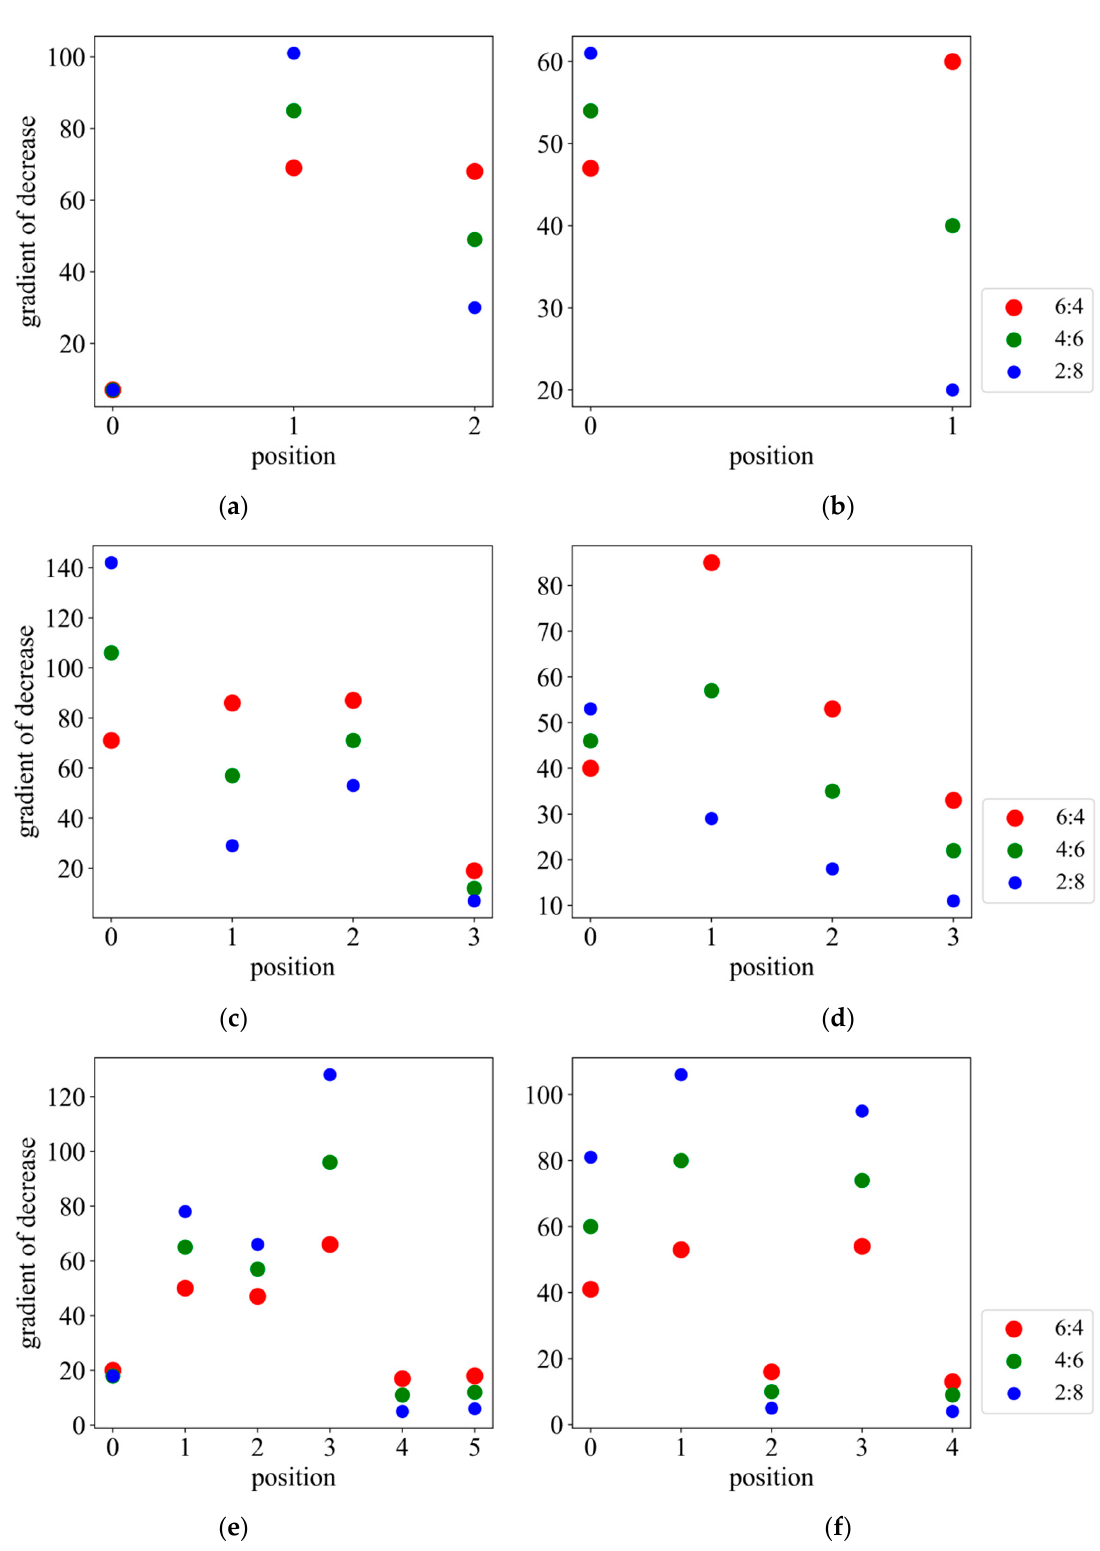
Figure 8. Scatter plots of gradient of decrease near the lake boundary with different weight settings: ( a ) result of the 14th row of Landsat TM image; ( b ) result of the 16th row of Landsat TM image; ( c ) result of the 18th row of Landsat ETM+ image; ( d ) result of the 19th row of Landsat ETM+ image; ( e ) result of the 19th row of Landsat OLI image; ( f ) result of the 27th row of Landsat OLI image. The response of lake boundary in the gradient image of water index is wide, which means that the change of gradient near the lake boundary is weak. In Figure 8, when the value of blue point is low, the values of red point and green point are both higher than